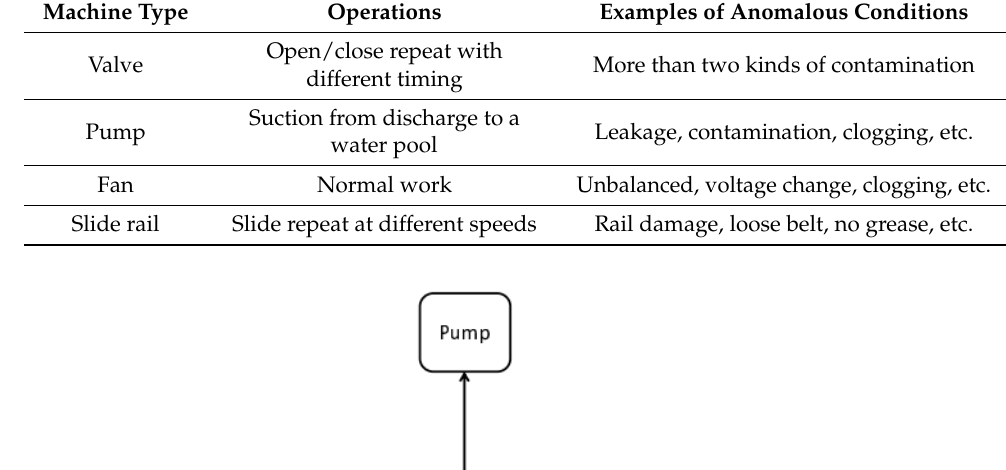
Table 8. Imbedded faults in MIMII real machines [10].